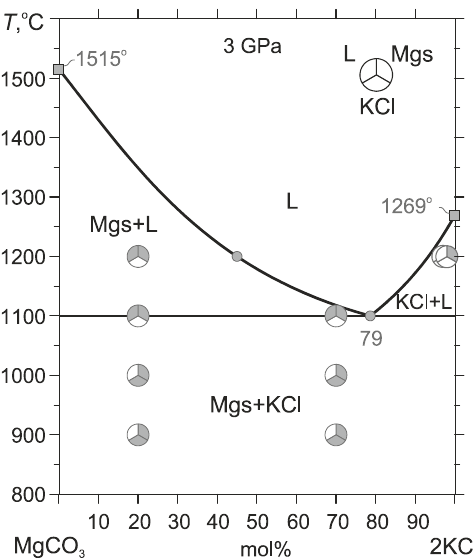
Figure 4. T - X diagram for the system KCl–MgCO 3 at 3 GPa. The MgCO 3 melting point is after [37]. See the caption for Figure 2 for other details.